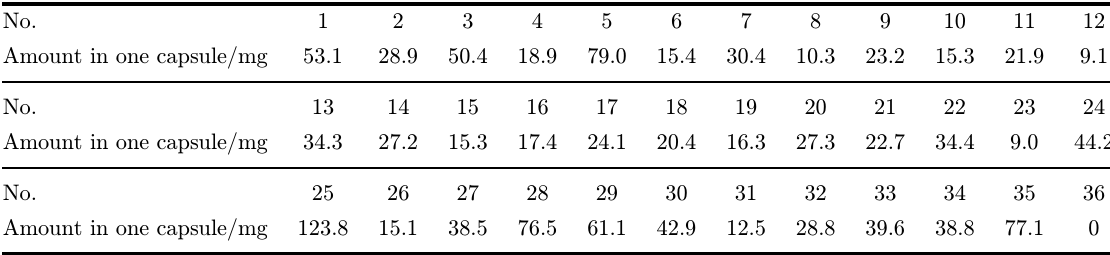
Table 6. Positive samples with metformin and negative samples without metformin. No. Amount in one capsule/mg